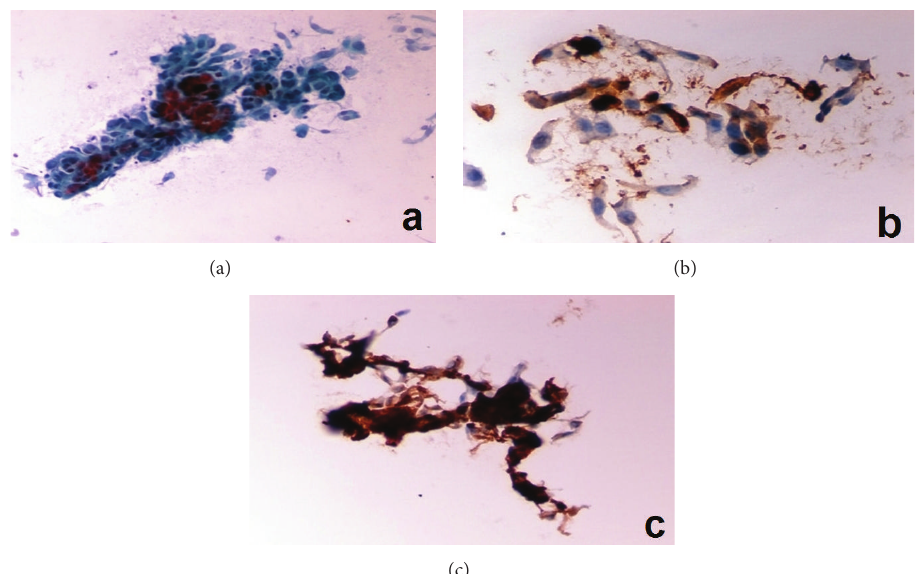
Figure 3: (a) Cytology-SCC (Pap stain, conventional × 400). (b) Immunocytochemistry-SCC with VEGF expression 2+ (ThinPrep × 400). (c) SCC with VEGF expression 3+ (ThinPrep × 600).